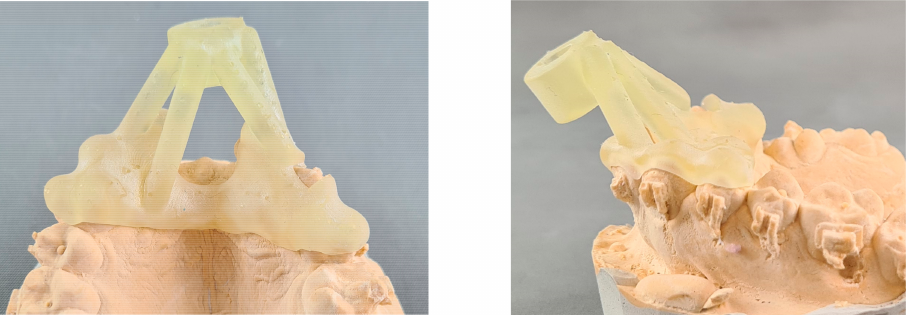
Figure 3. Three-dimensional printed surgical guide for orthodontic placement of orthodontic TAD to support provisional crowns in the esthetic